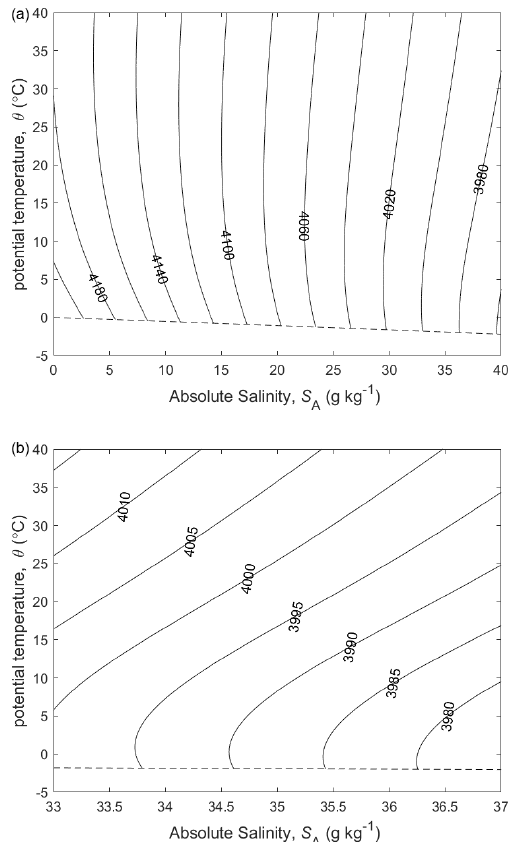
Figure 1. (a) Contours of the isobaric specific heat capacity c p of seawater (in Jkg − 1 K − 1 ) at p = 0dbar. (b) A zoomed-in version for a smaller range of Absolute Salinity. The dashed line is the freez- ing line at p =